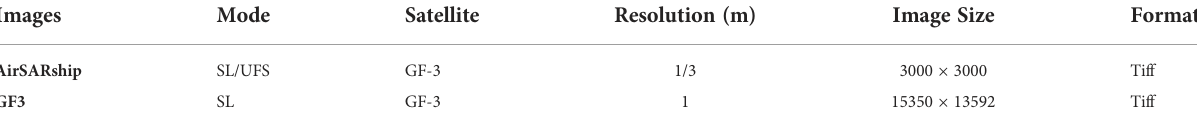
TABLE 5 The details descriptions of two SAR large scene